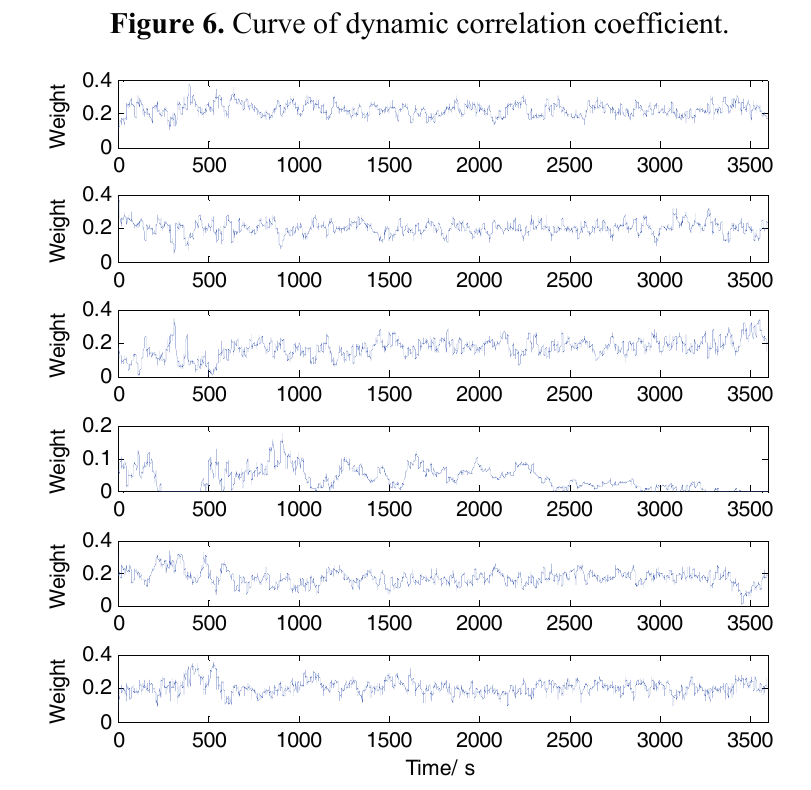
Figure 7. Weights of the individual